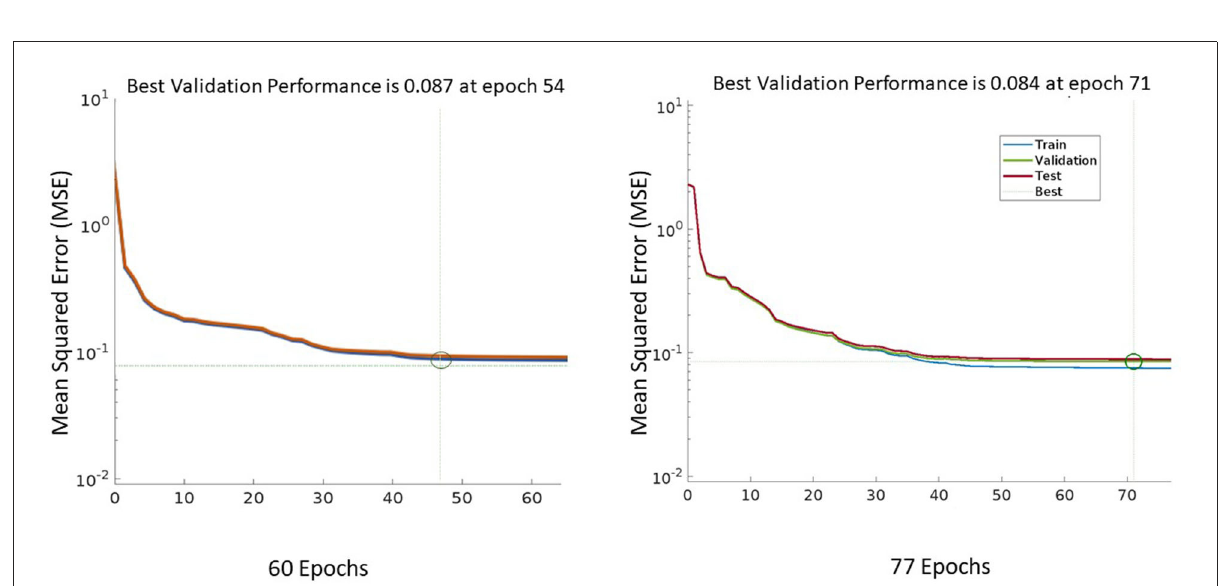
FIGURE10 The performance Mean Squared Error (MSE) of the model learning with the window size of 100 time steps (on the right side) is higher than the performance of the model on the left side with the window size of 50 time steps. MSE is the loss function which is indicated by the loss value between the prediction and the ground